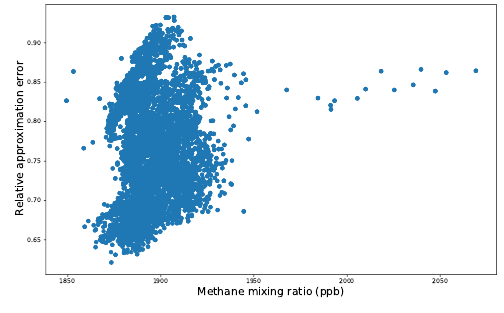
Figure 4. The highlighted areas indicate the wavelengths belonging to the wavelength mask. The absorption spectra are shifted along the y-axis for display purposes.